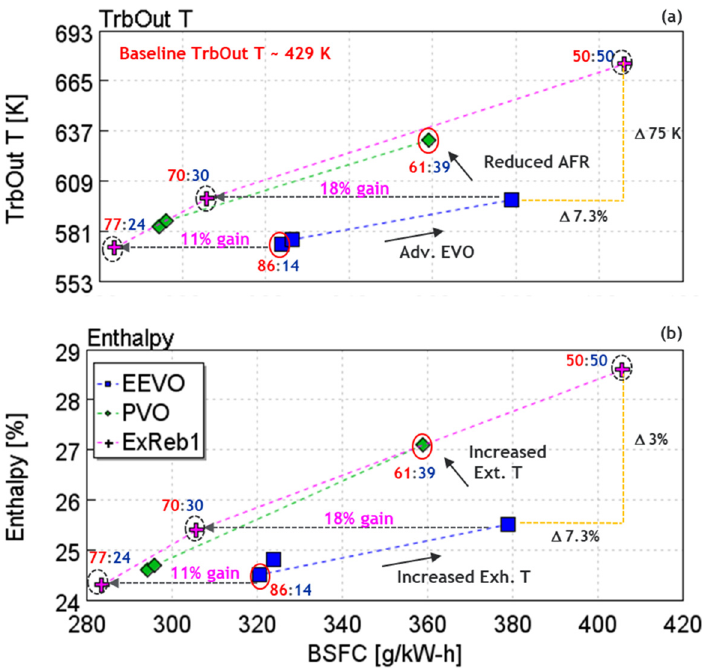
Figure 22. Comparison of all VVA strategies in terms of ( a ) TrbOut T and ( b ) exhaust enthalpy increase trends with respect to BSFC (for the elevated Tivc levels from Table 4).